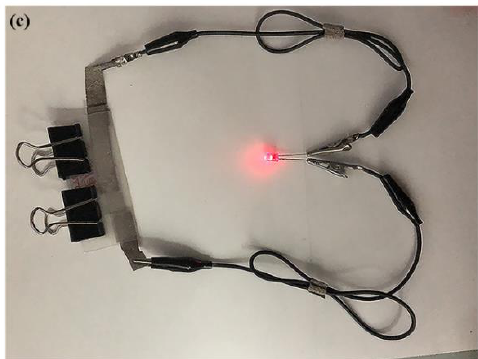
Figure 7. Electrochemical performance of ACF-10.3% PDPP-based symmetric supercapacitor: ( a ) long-term cycle stability test at a current density of 10 A·g −1 ; ( b ) CV curves of ACF-10.3% PDPP bended by different angles (0°, 90° and 180°) at a scan rate of 100 mV·s −1 ; and ( c ) digital photo images of a red LED powered by three devices in series.